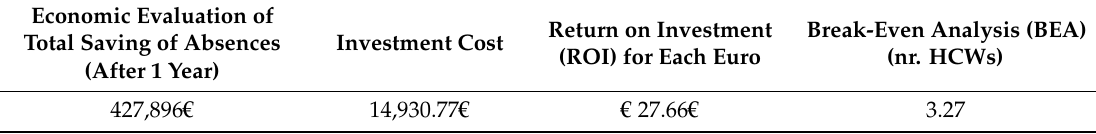
Table 4. Return on Investment (ROI) and Break-Even Analysis (BEA) of the WDMP.